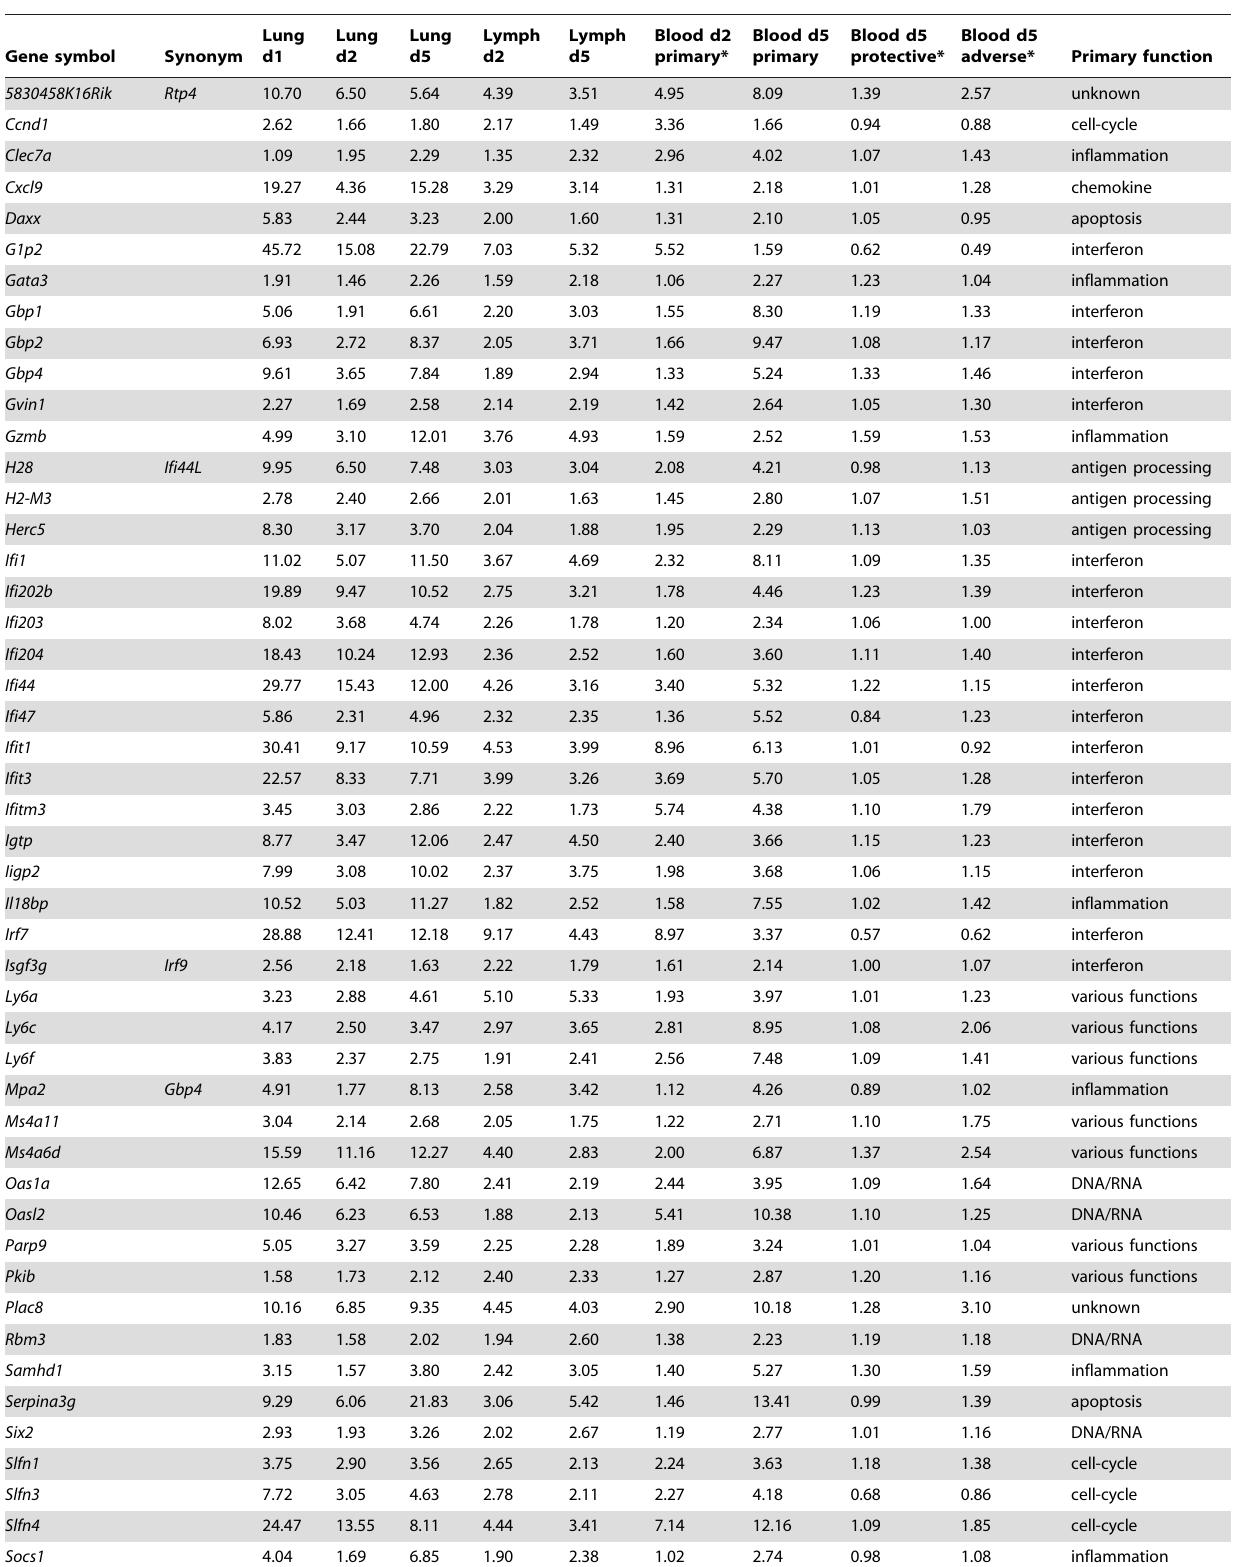
Table 1. Gene expression changes upon RSV infection in mice for the shared set of 53 genes in lung, lymph node, and blood on days 1, 2, and